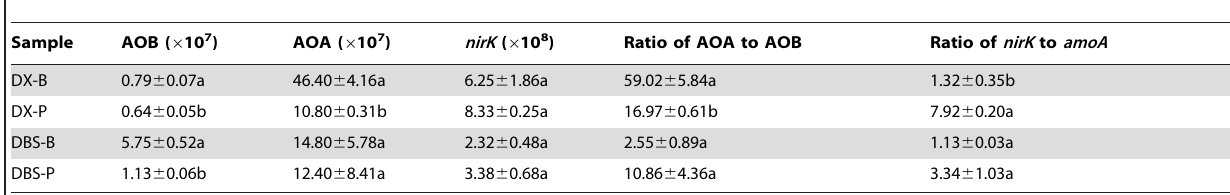
Different lowercase characters indicate significant different ( p , 0.05) between polluted soils (PS) and background soils (BGS) in a single site.